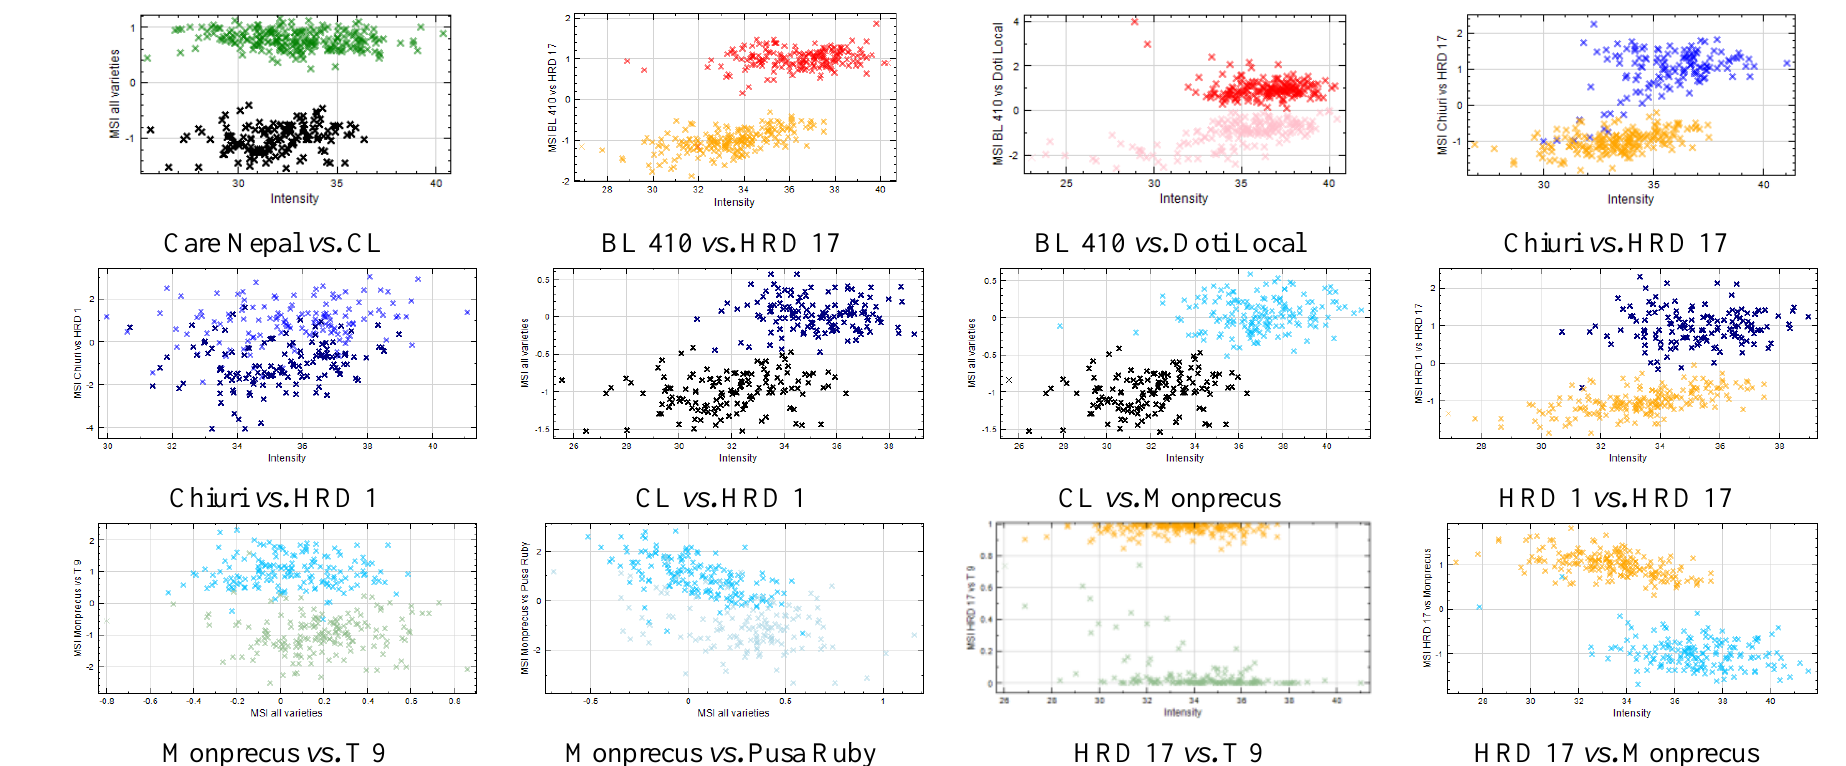
Figure 6. nCDA pairwise discrimination of randomly selected